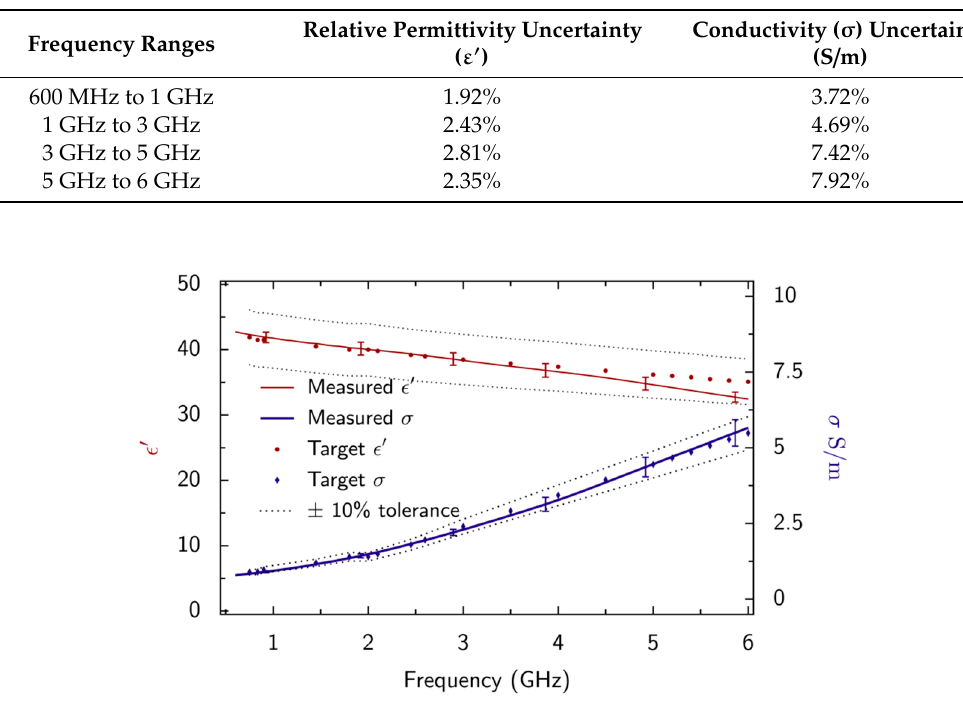
Figure 5. Dielectric properties of the broadband phantom liquid and IEC 62209 target values [13,14] between 600 MHz and 6 GHz, at 22 °C. The observed Type A uncertainty associated with measurements made by using the 85070E 3.5 mm probe (Table 1) is also plotted for a coverage factor of k = 2 (equivalent to 95% confidence level).